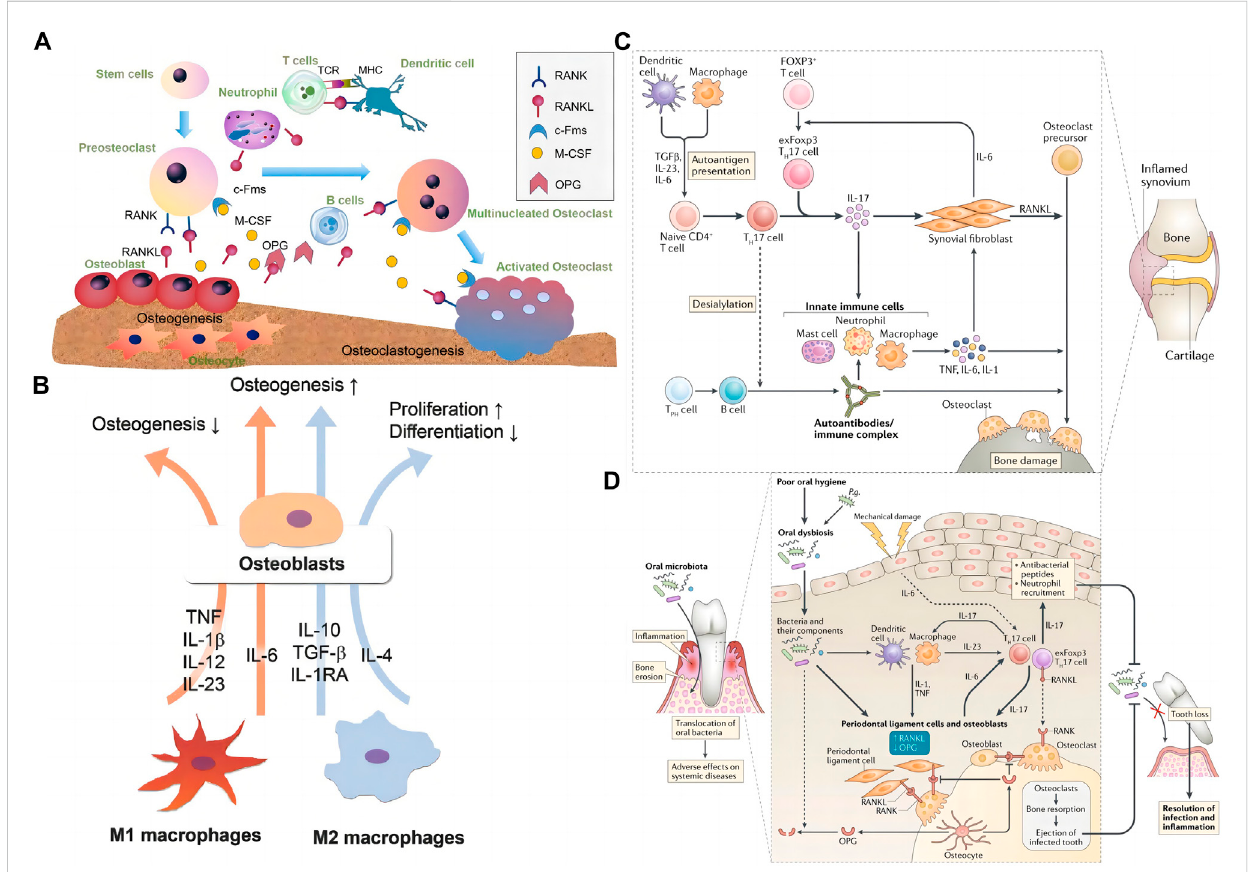
FIGURE 3 The interaction of the skeletal system and the immune system. (A) Interaction between skeletal and immune cells by secreting related factors, the graphwasreprintedwithpermissionfrom(Xieetal.,2020). (B) M1andM2interactwithosteoblaststhroughcytokinessuchasIL-6,IL-23,IL-10,andTGF- β . The graph was reprinted with permission from (Lee et al., 2019). (C) T cells, macrophages, and neutrophils ’ role in rheumatoid arthritis-induced bone erosion, the graph was reprinted with permission from (Tsukasaki and Takayanagi, 2019). (D) The role of T cells, macrophages, and DCs, in bacterial periodontitis-induced bone erosion, the graph was reprinted with permission from (Tsukasaki and Takayanagi,